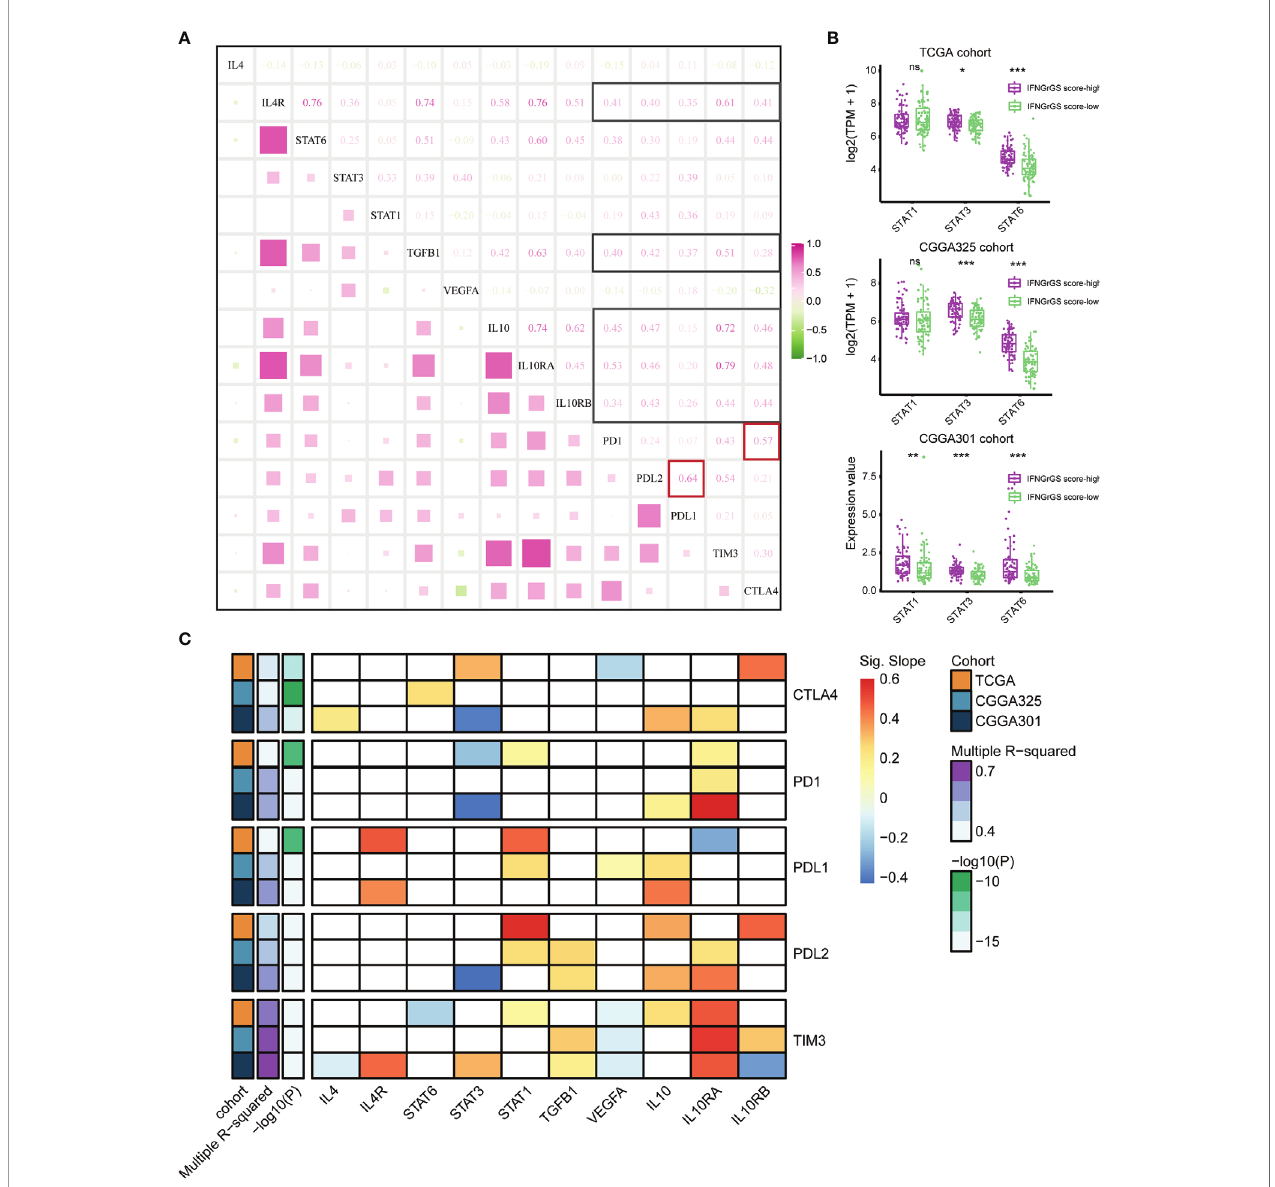
FIGURE 4 | Exploration of the regulatory pattern of immune checkpoint expression in GBM. (A) Correlation analysis between the main components of IFNG, IL4, IL10, TGF-beta, and VEGF pathways and immune checkpoints based on the TCGA cohort. Black boxes highlight the correlation of IL4R, TGFB1, and IL10/IL0RA/ IL0RB with immune checkpoints. Red boxes highlight the correlation between PD1 and CTLA4, PDL1, and PDL2. (B) The expression of STAT1, STAT3, and STAT6 between the IFNGrGS score-high and -low groups. (C) Multiple linear regression analysis. The horizontal axis is the putative independent variable that regulates the expression of immune checkpoints and the vertical axis is the dependent variable. The color represents the slope of the calculated linear regression equation which indicates the direction and degree of in fl uence of the independent variable on the dependent variable. Red means that the expression of the dependent variable increases with the independent variable, while blue is the opposite. The white boxes indicate that the effect of the independent variable on the dependent variable is insigni fi cant. Multiple R-squared indicates the extent to which the independent variables determine the expression of the dependent variable. *p < 0.05, **p < 0.01, ***p < 0.001, and ns, non-signi fi